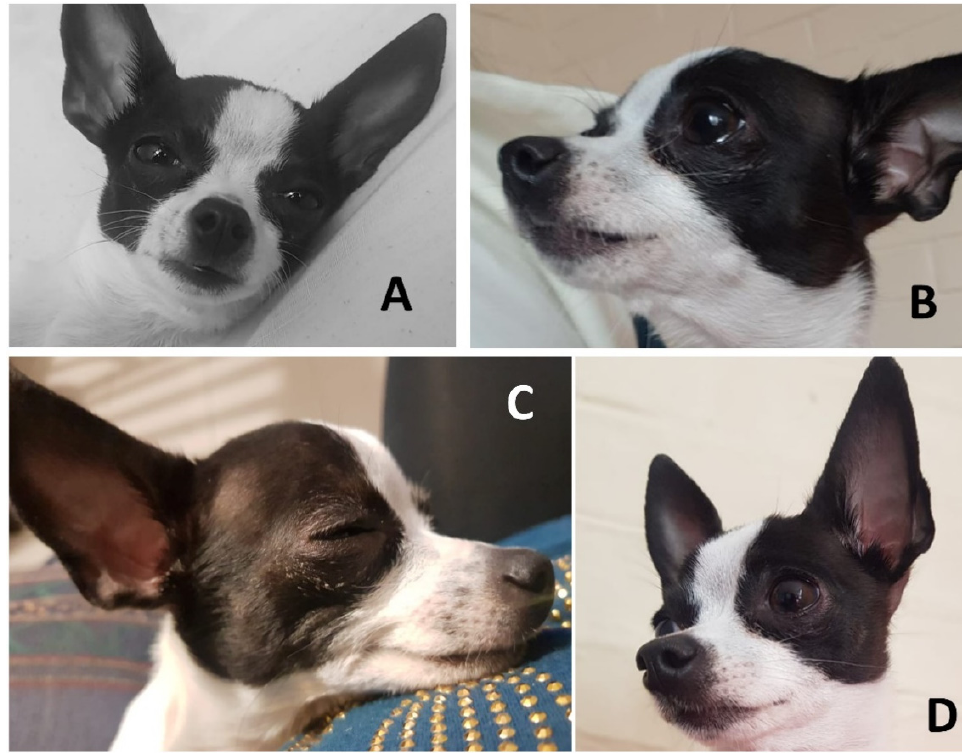
Figure 5. Facial expressions in dogs and their links to humans. Image of a one-year-old female Chihuahua showing marked changes in facial expressions upon recognizing similar emotions in her owner’s gestures. ( A ) Neutral. Relaxed expression; ( B ) Sadness. Broad forehead, large eyes, ears erect with caudal inclination, closed snout; ( C ) Pleasure. Tension in the labial commissure, eyes semi-closed with facial mimicking that simulates the form of a human smile; ( D ) Surprise. Eyebrows raised to show apparently larger, more expressive eyes, with ears raised and labial tension.